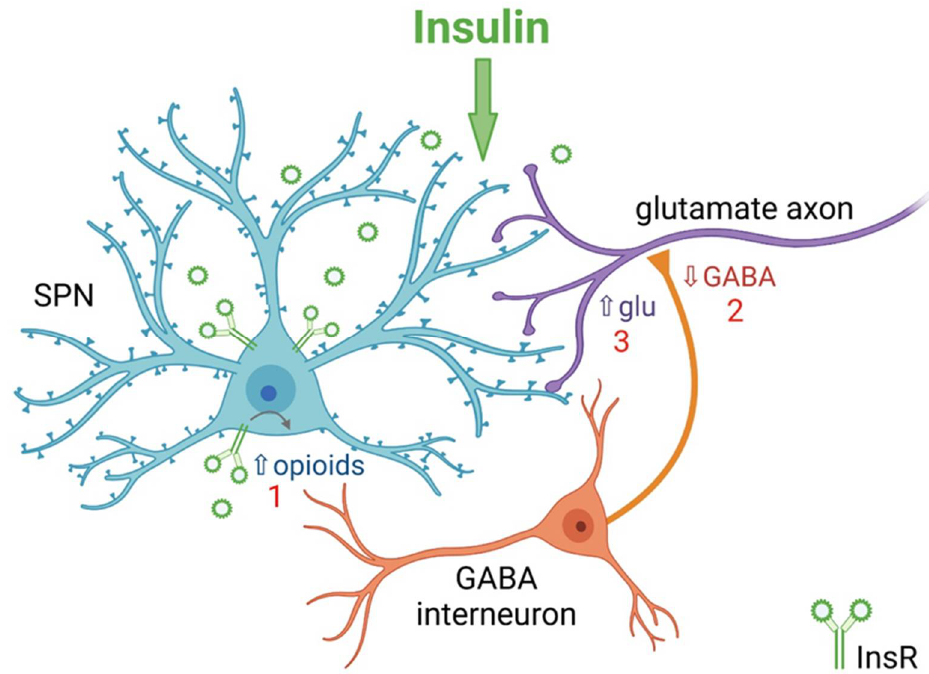
Figure 3. Summary of mechanism by which insulin increases excitatory regulation of striatal pro- jection neurons (SPNs) in NAc core. 1. Activation of insulin receptors (InsRs) on GABA/opioid containing SPNs in rat nucleus accumbens (NAc) core increases the release of endogenous opioids. 2. Opioid activation of GABAergic interneurons decreases GABA release onto glutamatergic inputs from cortex and thalamus. 3. Decreased GABA release from GABAergic interneurons disinhibits glutamatergic inputs resulting in increased presynaptic glutamate (Glu) release onto dendritic spines of SPNs. Higher concentrations of insulin act at insulin-like growth factor-1 receptors (IGF-1Rs) to oppose this process (not shown). Based on [78].